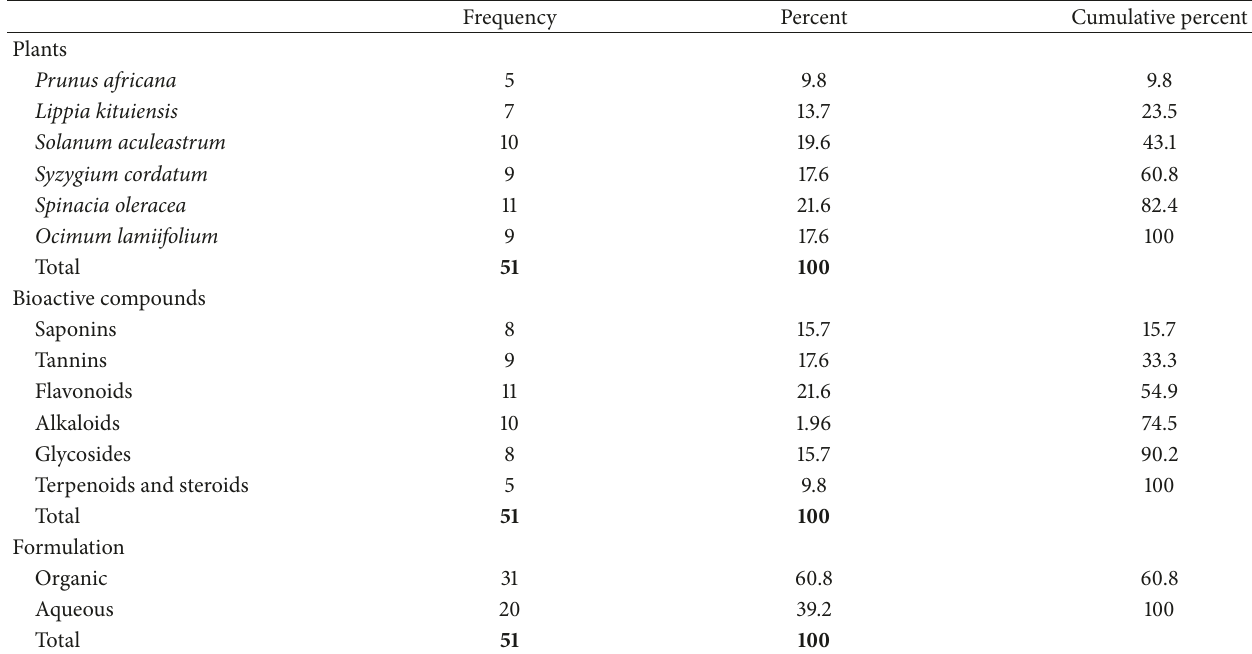
Table 7: Frequency of bioactive compounds in plant extracts. Frequency Percent Cumulative